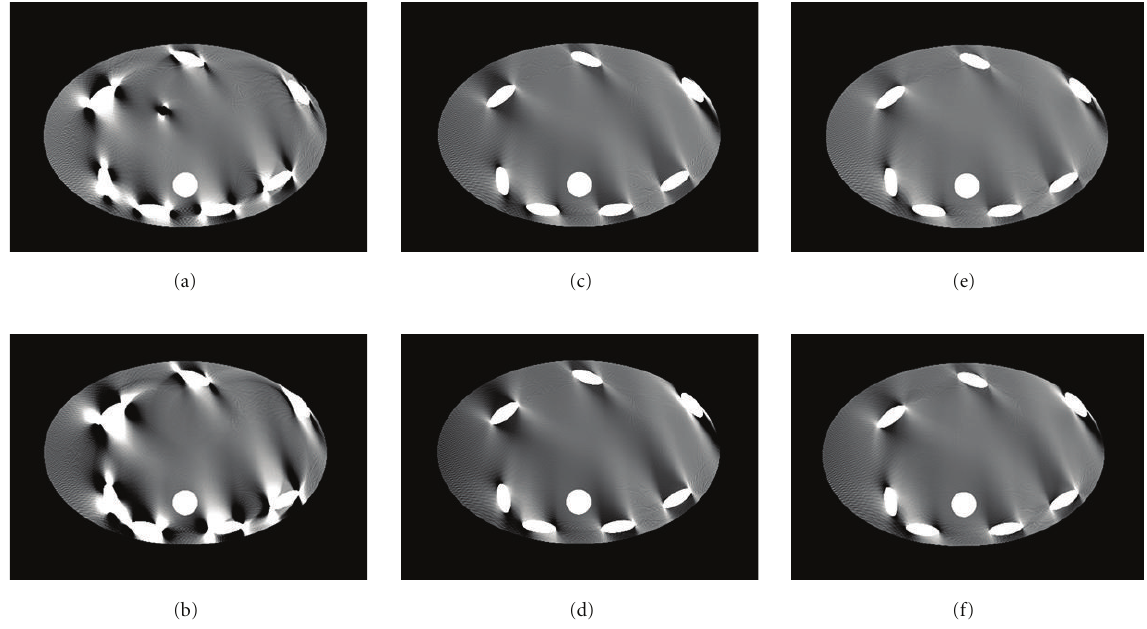
Figure 12: Worst-case images from (a) 3rd generation CT system with 40 mm coverage, (b) 3rd generation CT system with 80 mm coverage, reconstructed using FDK with Parker weighting approach, (c) multi-axial acquisition CT system with 120 mm coverage, (d) multi-axial acquisition CT system with 160 mm coverage, reconstructed with slice substitution approach using FDK parker weighting slices, (e) multi- axial acquisition CT system with 120 mm coverage, and (f) multi-axial acquisition CT system with 160mm coverage, reconstructed with cone-angle dependent weighting reconstruction. Grayscale: ( − 50HU, 50HU). Note that the worst-case slices for 3rd generation system are the slices located at the edge of scan FOV, and the worst-case slices for multi-axial acquisition system are the slices located in between two